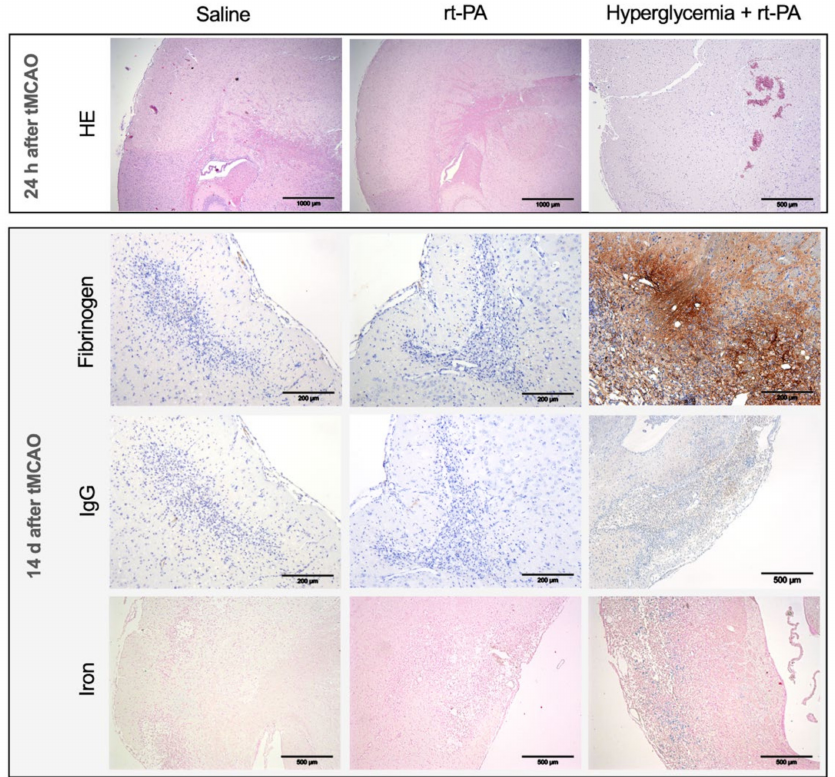
Figure 4. Representative stainings for groups treated 24 h or 14 days after experimental stroke. Depending on treatment group (rows), stainings for HE, fibrinogen, IgG and iron are presented. Sections of the right hemisphere are depicted at magnification 4 × (bars 1000 µ m) up to 20 × (bars 200 µ m). Hyperglycemic mice showed an increased extent of cerebral microhemorrhages after recombinant tissue plasminogen activator (rt-PA) treatment. Additionally, an increase of fibrinogen and immunoglobulin (Ig) G extravasation as a hallmark of blood–brain barrier breakdown could be seen sporadically in hyperglycemic mice, but a high variation of IgG and fibrinogen extravasation was detected without any difference in lesion size or localization of stroke. Statistical significance was not